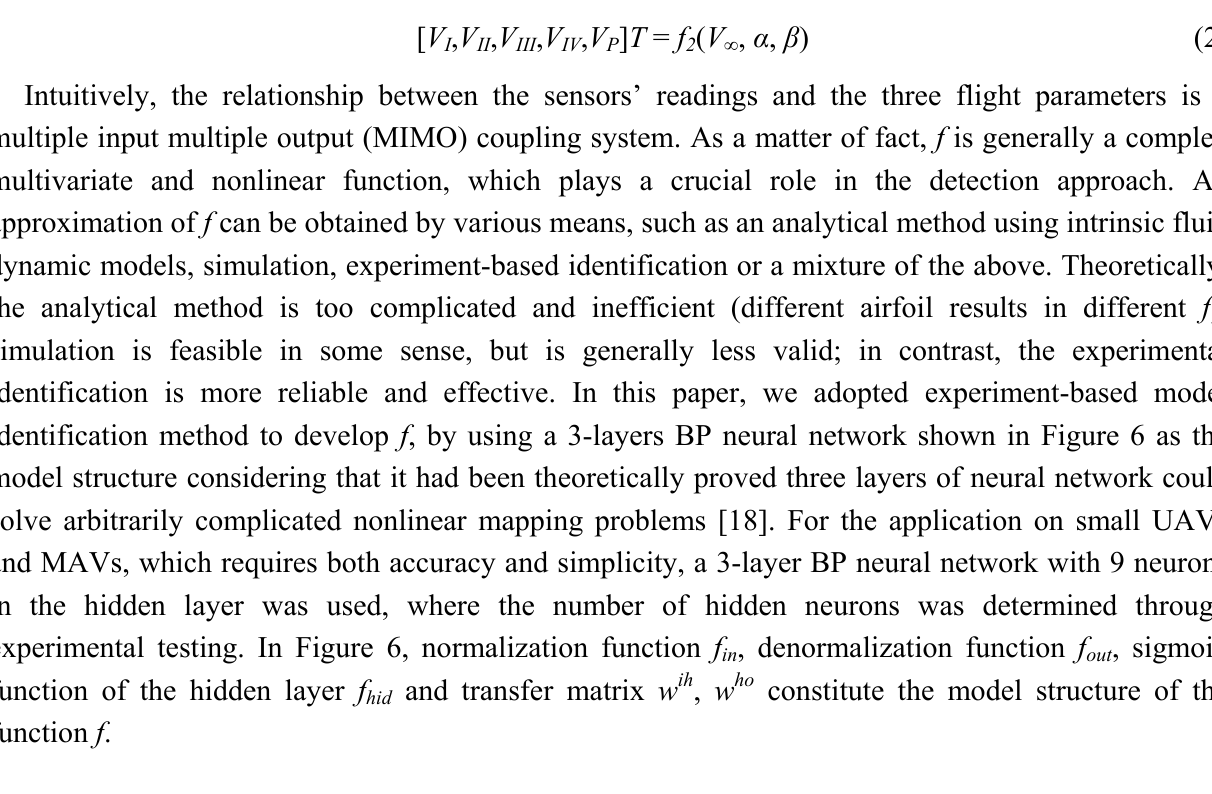
Figure 6. Structure of the neural